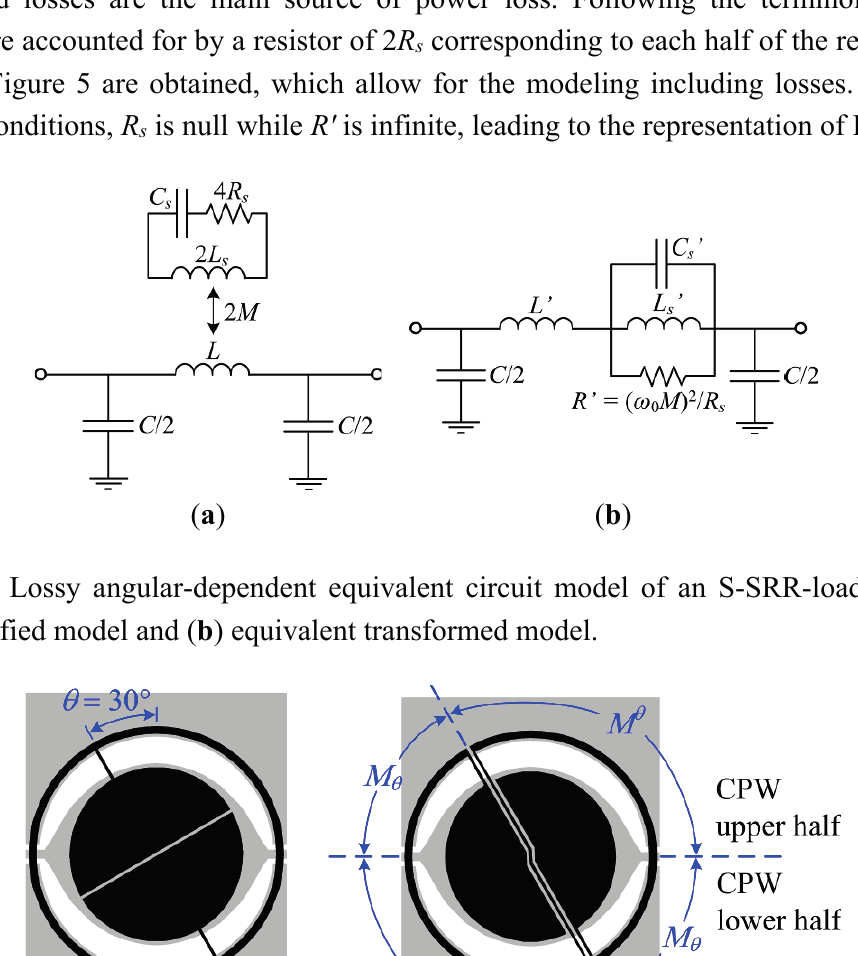
r 0 = 8.05 mm, circular patch outer radius r 1 = 5.6 mm, c 1 = s = 0.2 mm, and c 2 = 0.5